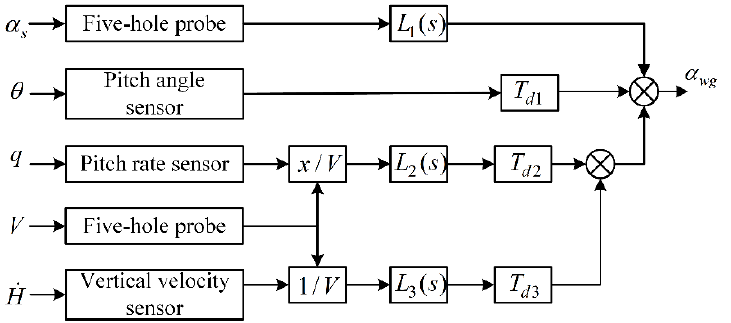
Figure 8. Sensor signals ’ fusion for gust calculation.